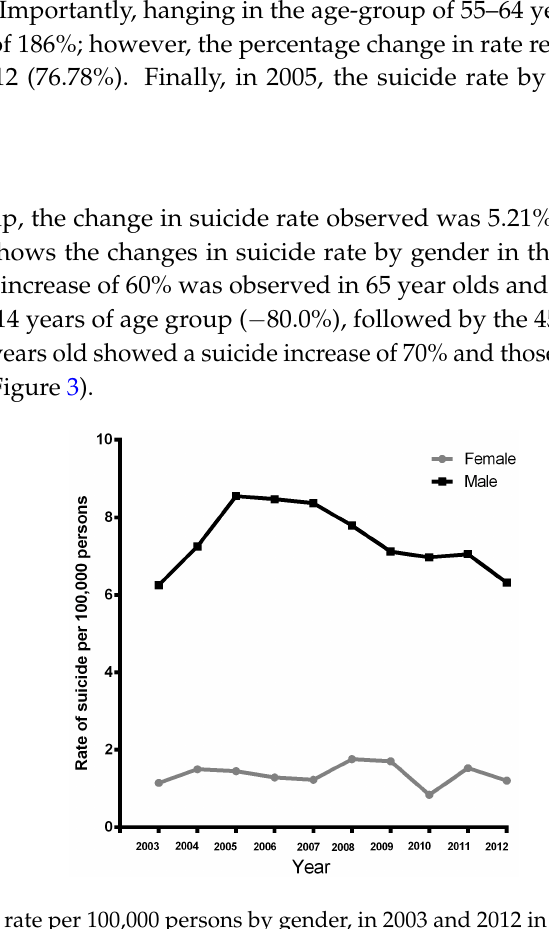
Figure 2. Suicide rate per 100,000 persons by gender, in 2003 and 2012 in Mexican population. Int. J. Environ. Res. Public Health 2016 , 13 , 552